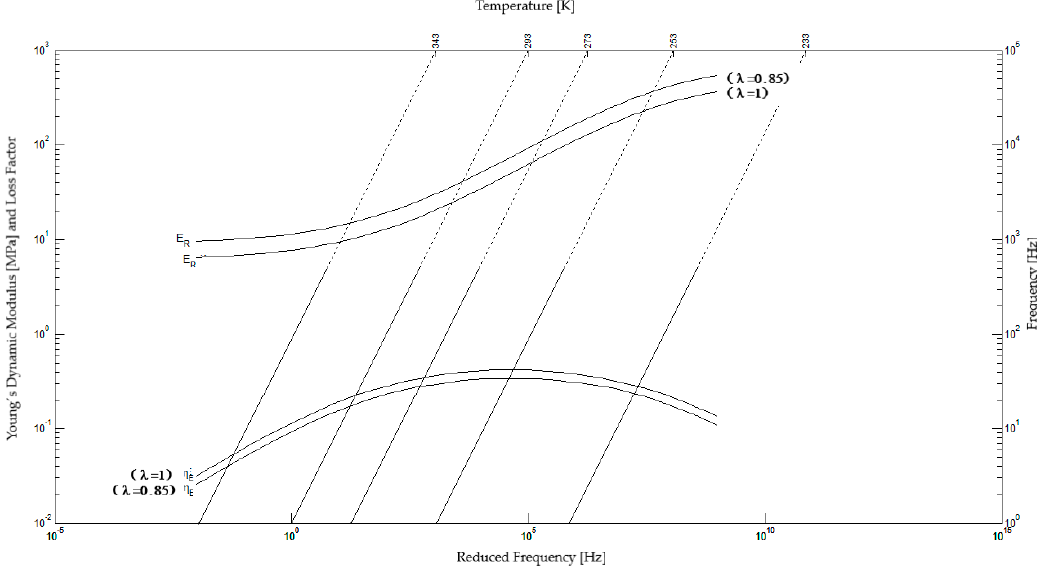
Figure 5. Reduced-frequency nomogram for Butyl Rubber for preloads of 0% and 15% of longitudinal strain [29].